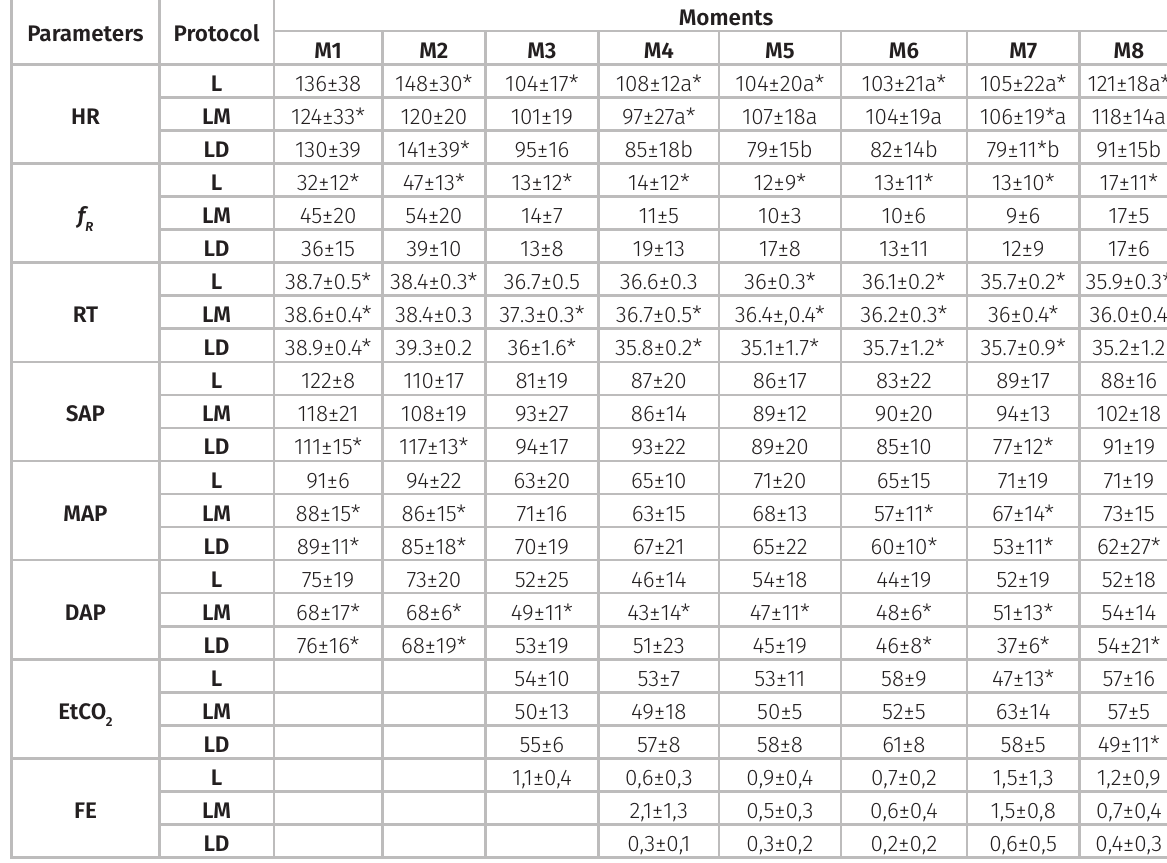
Table II. Mean ± standard deviation of the heart rate (HR), respiratory rate ( f (SAP), mean (MAP) and diastolic (DAP) blood pressure, end tidal CO bolus applied (FE) in bitches undergoing epidural anesthesia with levobupivacaine alone or combined with methadone or dexmedetomidine for unilateral total